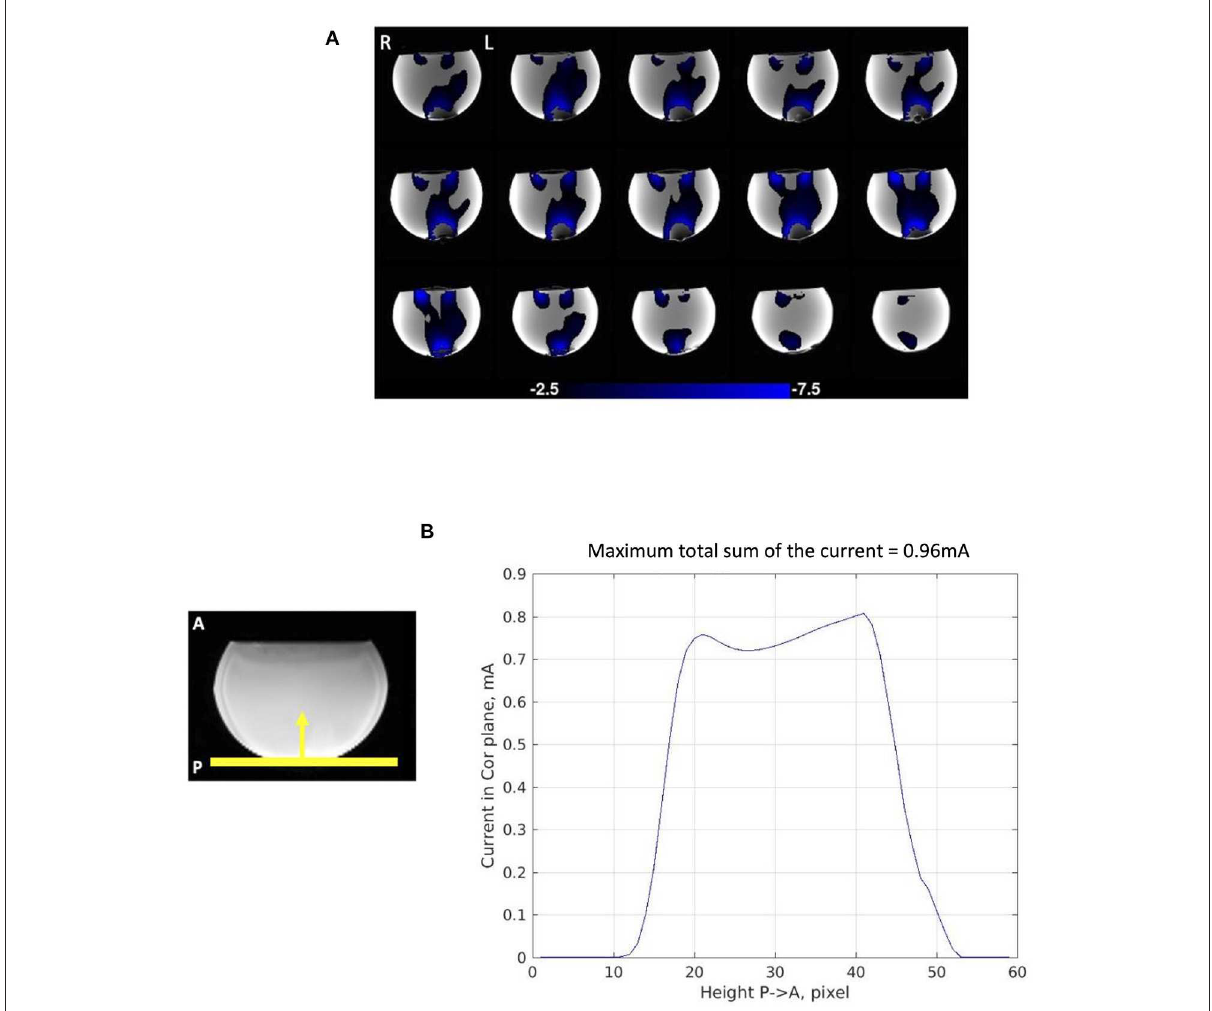
FIGURE3 Current distribution in phantom experiment. (A) Average current distribution map across the four consecutive stimulation scans showing 3-pixel-thick slab in which total current was measured as slab location was varied. The maps demonstrate Posterior (P) to Anterior (A) current flow (J y ) in the phantom. (B) Magnitude of Posterior (P) to Anterior (A) current flow (J y ) in the 3-pixel-thick slabs in the coronal plane averaged across the four consecutive scans. The maximum total sum of the current passing through the coronal plane is